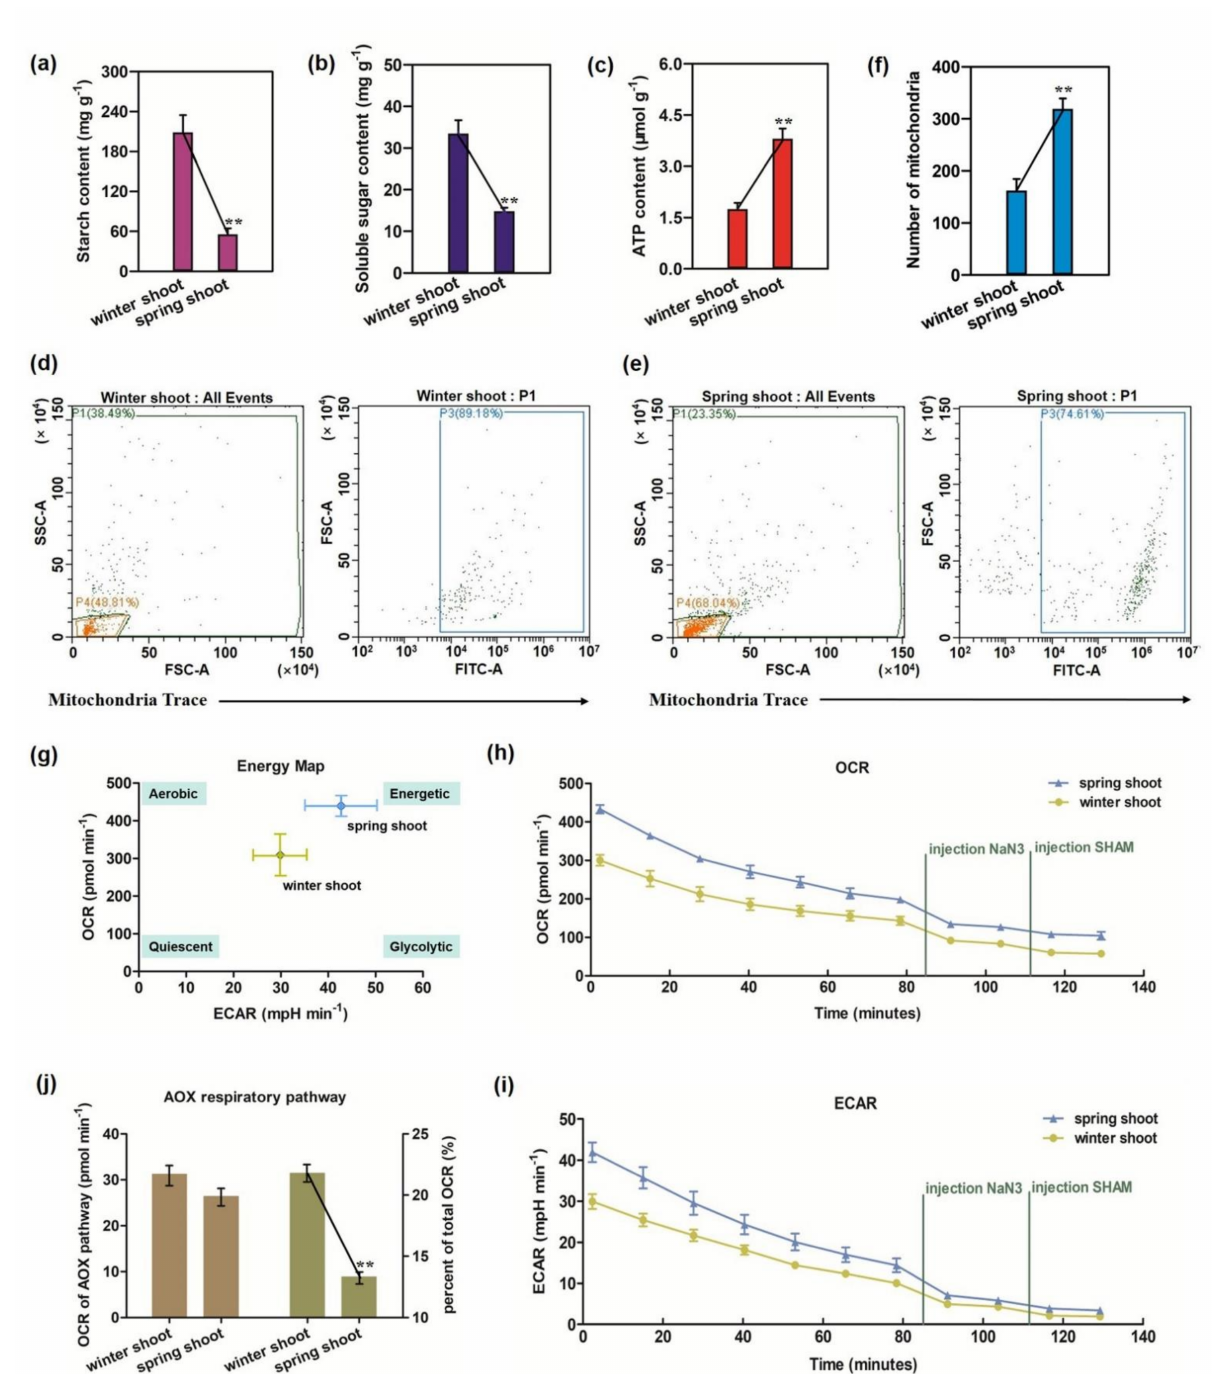
Figure 1. Analysis of physiological indexes related to energy metabolism in different development stages of Moso bamboo shoots. ( a ) Starch content analysis. ( b ) Soluble sugar content analysis. ( c ) ATP content analysis. ( d , e ) Mitochondria were sorted by CytoFLEX of 100 µ L purified mito- chondria suspensions of winter and spring shoots (P1, all particles; P3, mitochondrial particles; P4, noise data). ( f ) Number of mitochondrial particles per 100 µ L of purified mitochondrial suspension. ( g ) The initial OCR and ECAR of winter and spring shoots. ( h , i ) Changes to OCR and ECAR after adding COX and AOX respiratory inhibitors NaN3 and salicylhydroxamic acid (SHAM) into the respiration buffer. ( j ) OCR of AOX respiratory pathway and its proportion in total OCR. ** represents significant difference p <